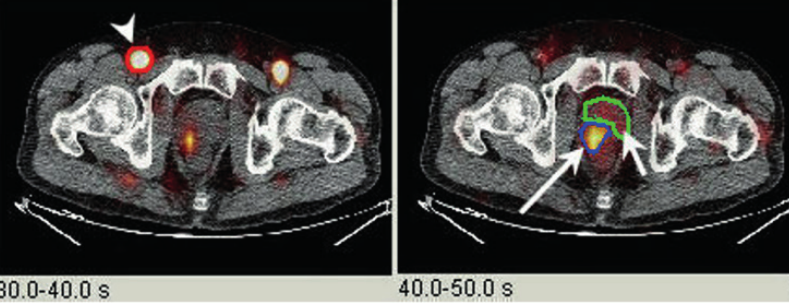
figure 1 - 11 c-choline pET / cT dynamic blood flow. Axial fused pET / cT sequential blood flow images (left: 30-40 seconds after injection; right: 40-50 seconds after injection) showing preferential arterial supply to the prostate tumor relative to background prostate tissue (arrowhead = iliac artery; large arrow = prostate cancer; small arrow = background prostate tissue).